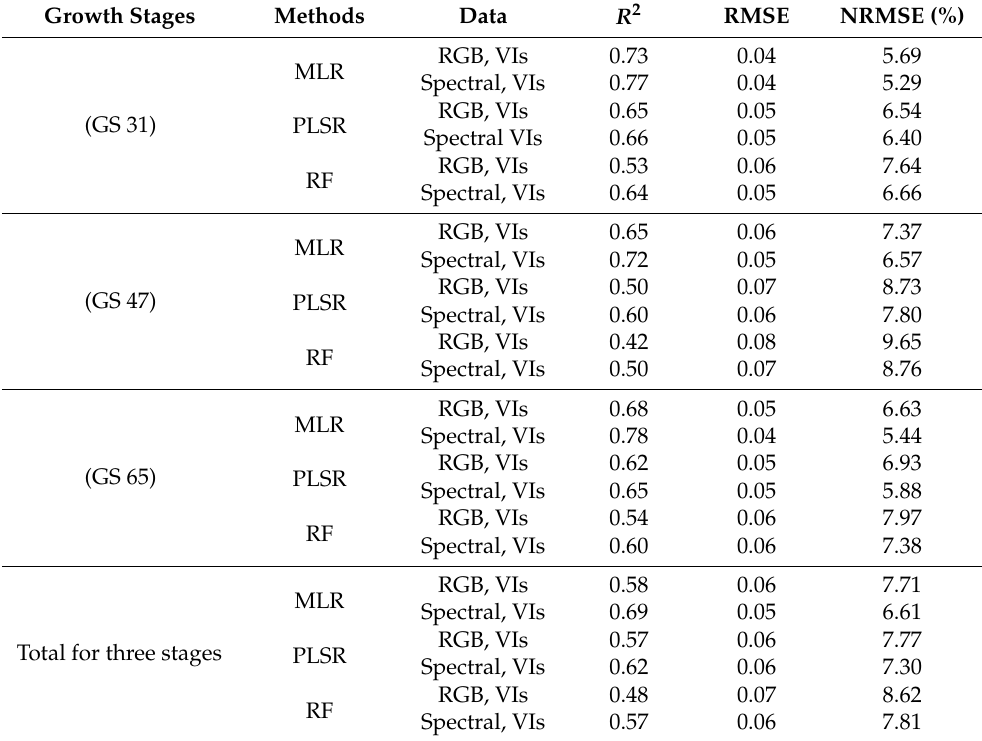
Table 5. Results of using different methods to estimate the CGI for different winter wheat growth stages. Growth